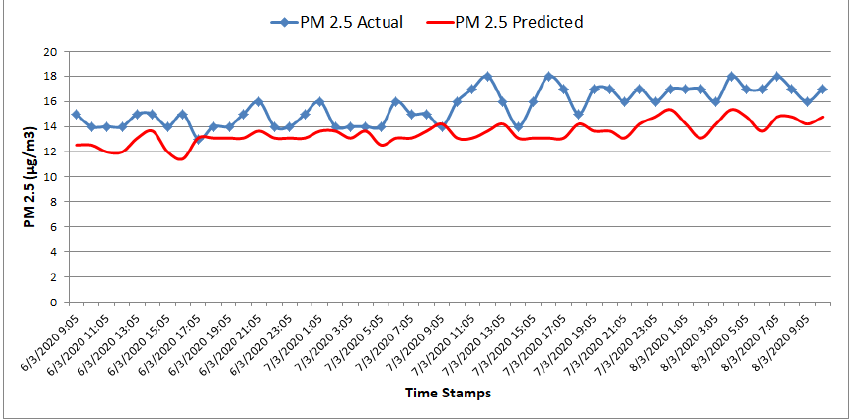
Figure 21. Hourly Predicted values of PM 2.5 vs. Actual